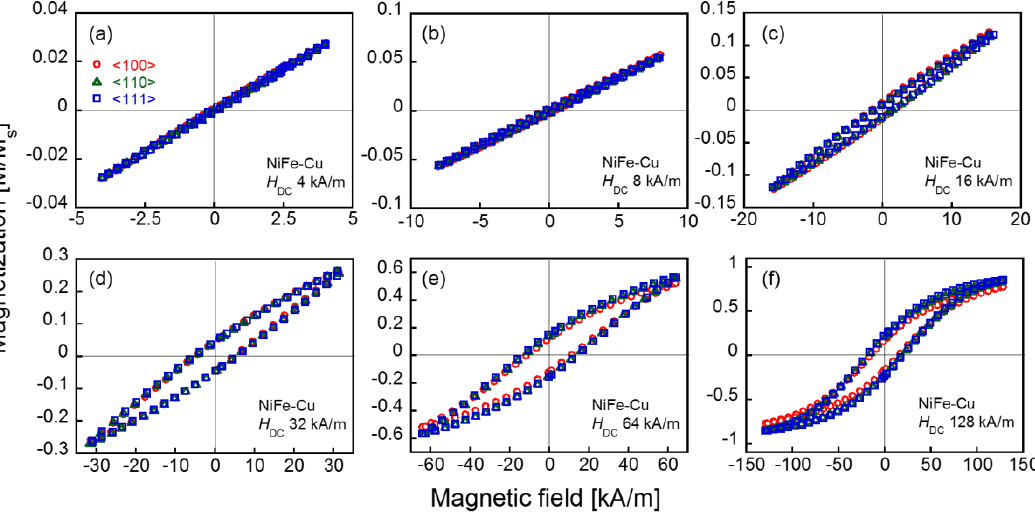
Figure 4. DC magnetization curves (minor loops) of the NiFe-Cu nanocubes recorded with the applied field intensities H DC of 4 kA/m ( a ), 8 kA/m ( b ), 16 kA/m ( c ), 32 kA/m ( d ), 64 kA/m ( e ), and 128 kA/m ( f ).